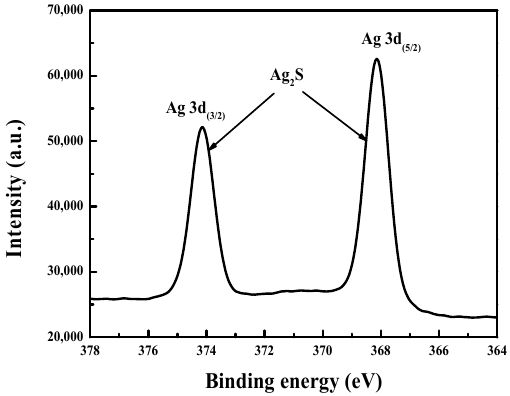
Figure 4. SEM images for the surfaces of arsenopyrite cuboids after bioleaching 36 h in 9K culture medium ( a ) without and ( b ) with 5 mg/L Ag + .